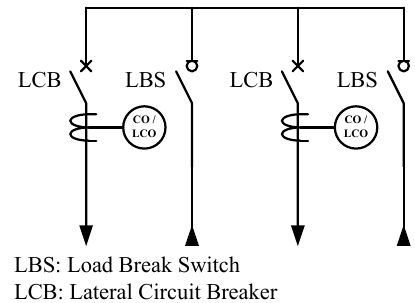
Figure 1. One-line diagram of underground 4-way automatic line